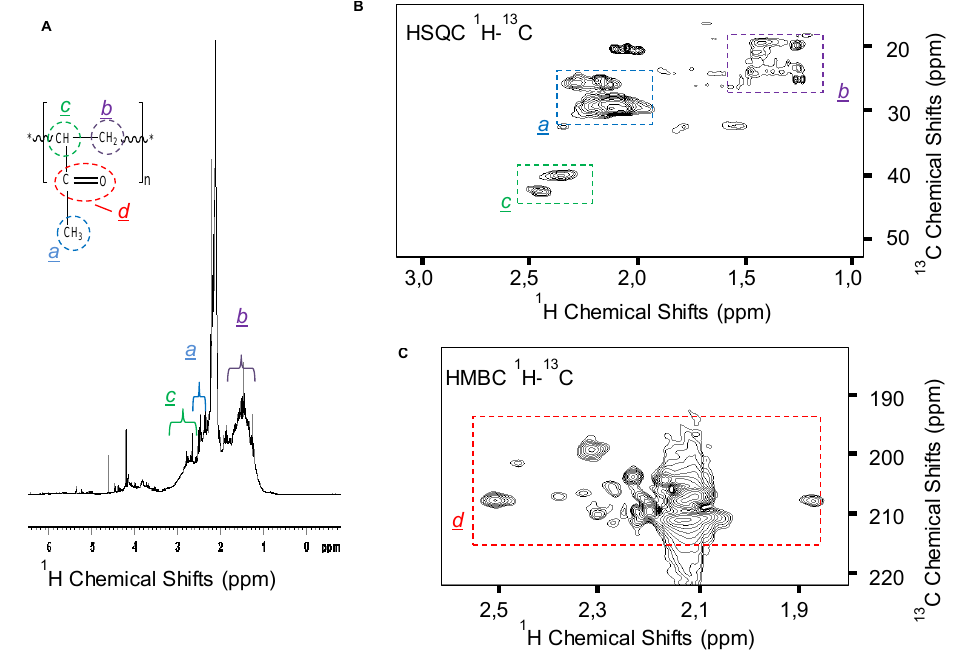
Fig. 3. Proposed structure identification of oligomers. 1D 1 H NMR spectrum (A) and 2D 1 H- 13 C NMR spectra (B and C) of a sample taken at 90 min of reaction during experiment A, freeze-dried and re-suspended in CDCl 3 .